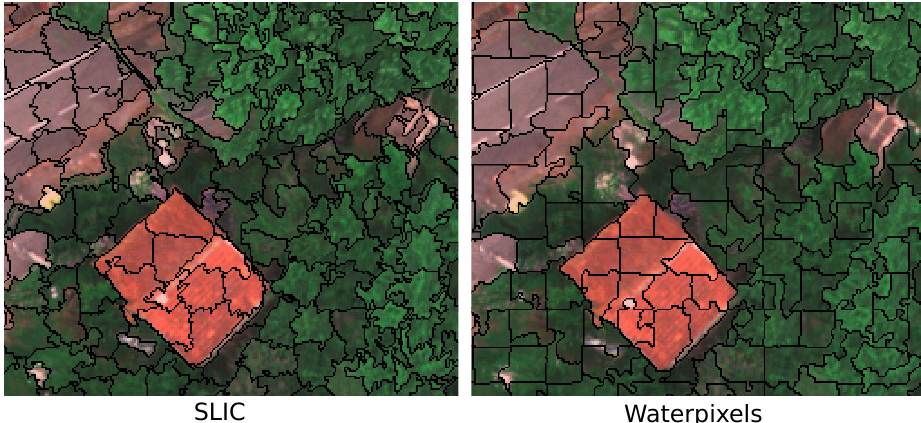
Figure 10. Examples of superpixel computation with segments of an approximate length of 20 pixels using SLIC and waterpixels segmentation